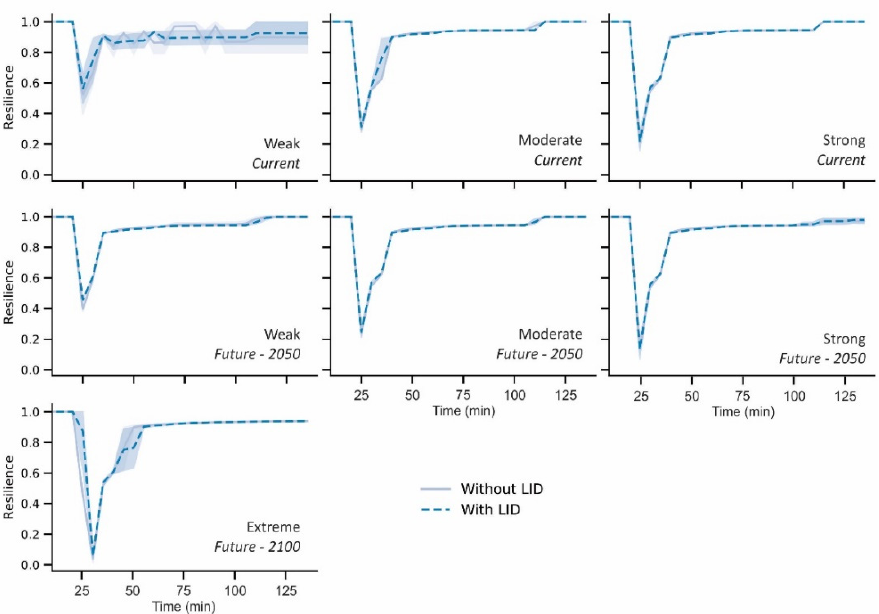
Figure 9. Resilience curves for current and future scenarios with and without applying LID prac ‐